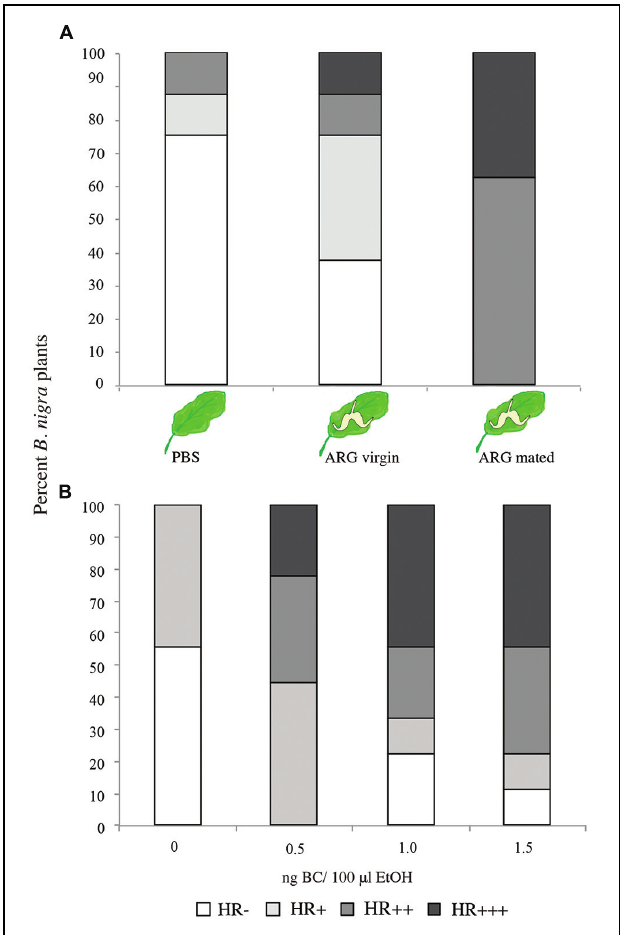
FIGURE 3 | Percentage of B. nigra plants treated with ARG secretion from P. brassicae females or anti-aphrodisiac compound expressing HR-like necrosis. (A) treatments with ARG secretions from P. brassicae females ( n = 8 plants/treatment, all treatments on one plant), (B) treatments with anti-aphrodisiac compound from P. brassicae females, benzyl cyanide (BC) at three different concentrations 0.5–1.5 ng/100 µ l ethanol (EtOH) or EtOH only ( n = 9 plants/ treatment. HR − : no necrosis observed, HR + to +++ : necrosis, which was assessed using a relative scale as shown in Figures 1A and 2A–C